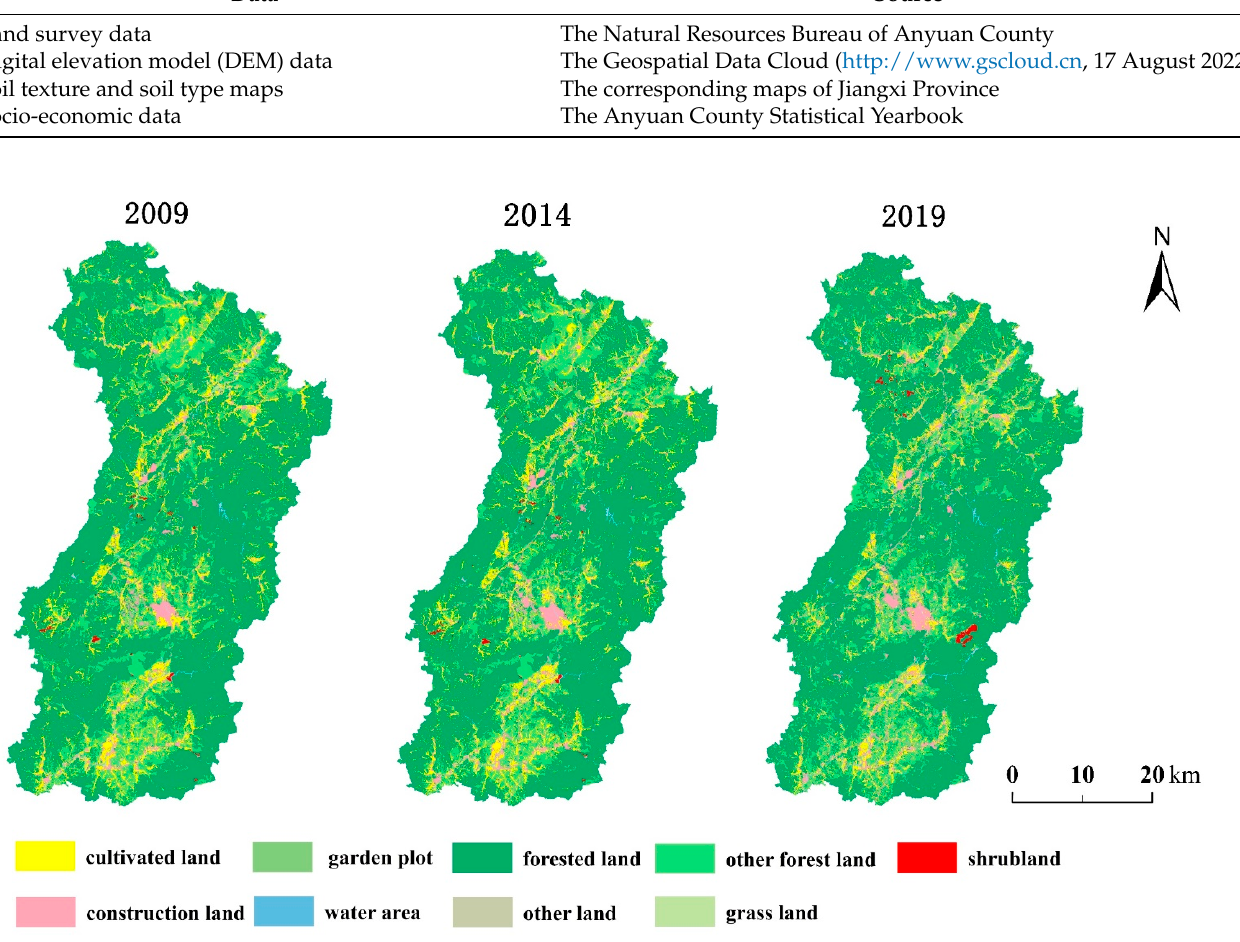
Figure 2. Distribution of major land use types in Anyuan County, 2009–2019.